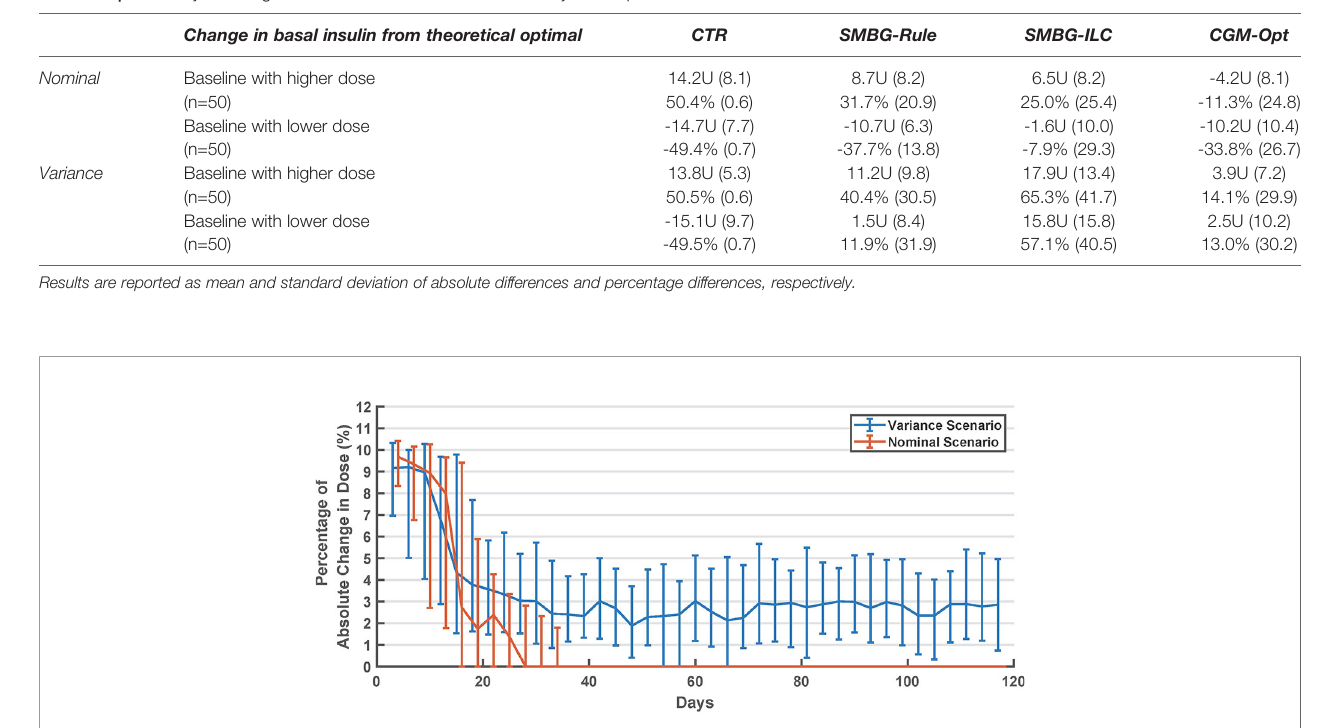
TABLE 2 | Summary of changes in basal dose from theoretical steady-state optimal value.